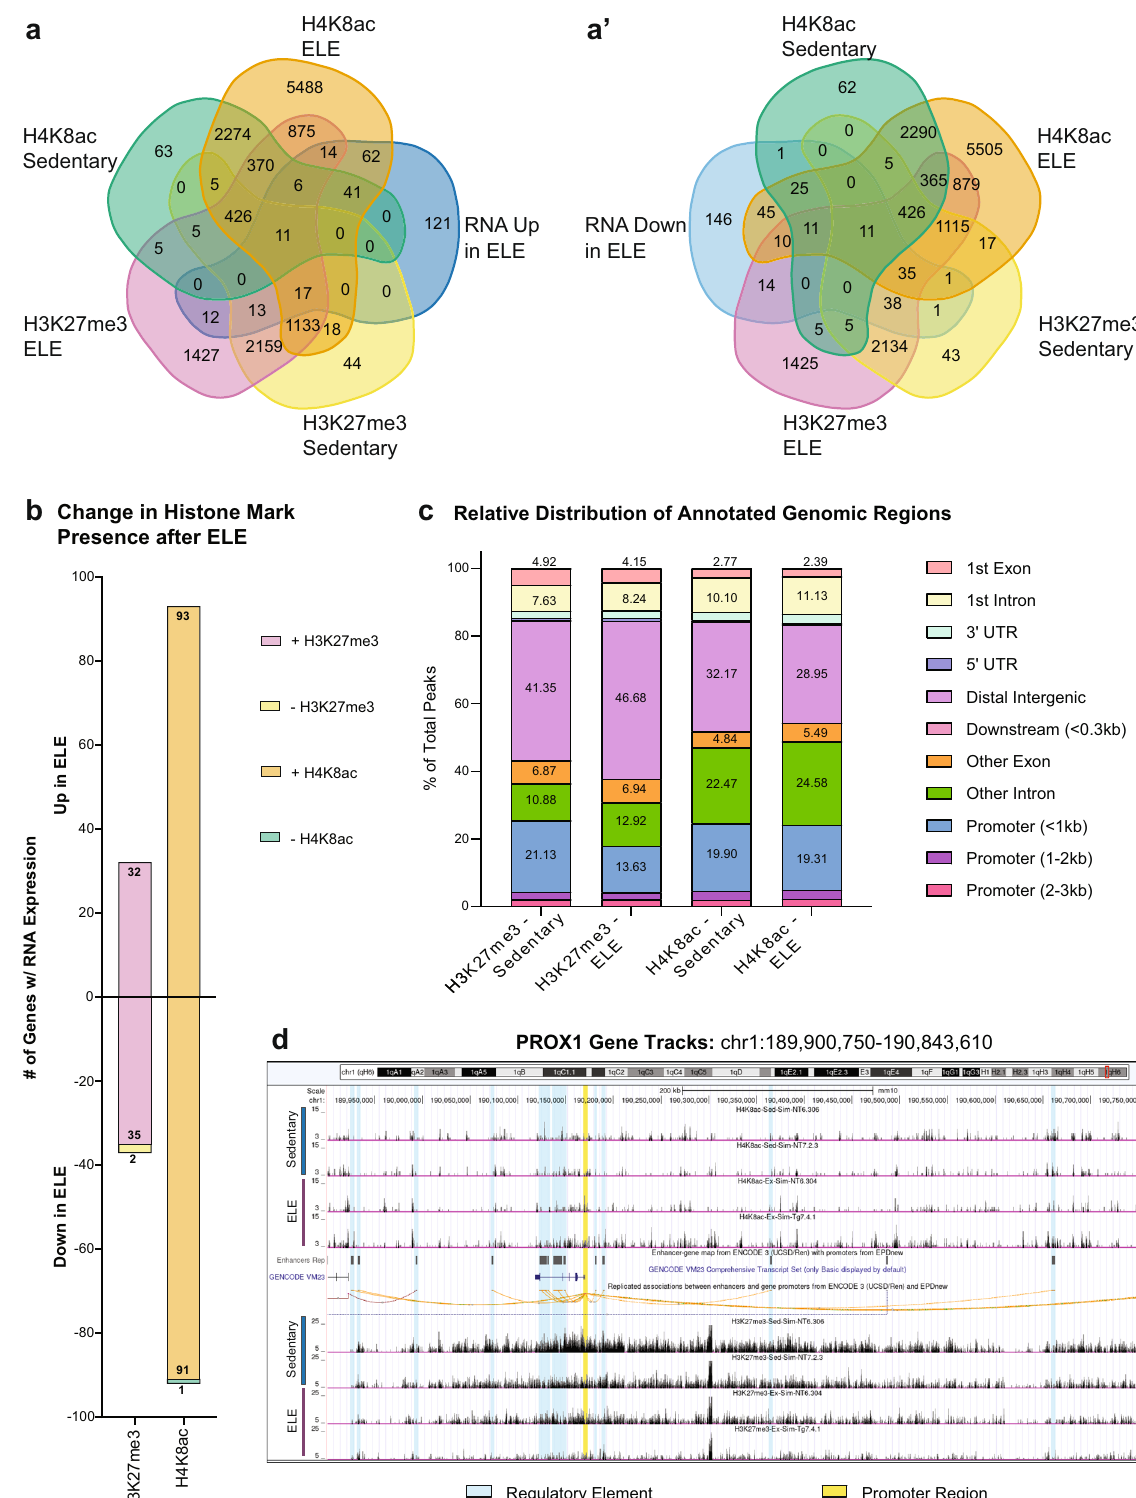
Fig. 5 ELE alters H4K8ac and H3K27me3 occupancy at differentially expressed genes. a Venn diagram of gene peaks identi fi ed in CUT&RUN-seq for H4K8ac and H3K27me3 by SEACR (top 1% of peaks FDR < 0.1) overlapped with genes upregulated ( a ) and downregulated ( a ′ ) in RNA by ELE ( n = 2 sedentary mice and n = 3 ELE mice). b CUT&RUN-seq SEACR peak calls at genes that overlap with genes differentially expressed by ELE as determined by TRAP-seq. c Stacked bar of the relative distribution of peak calls at various genomic regions identi fi ed by CUT&RUN-seq called using SEACR. d Representative track of CUT&RUN-seq data around Prox1 showing differential peak height between ELE and sedentary conditions for H4K8ac (top) and H3K27me3